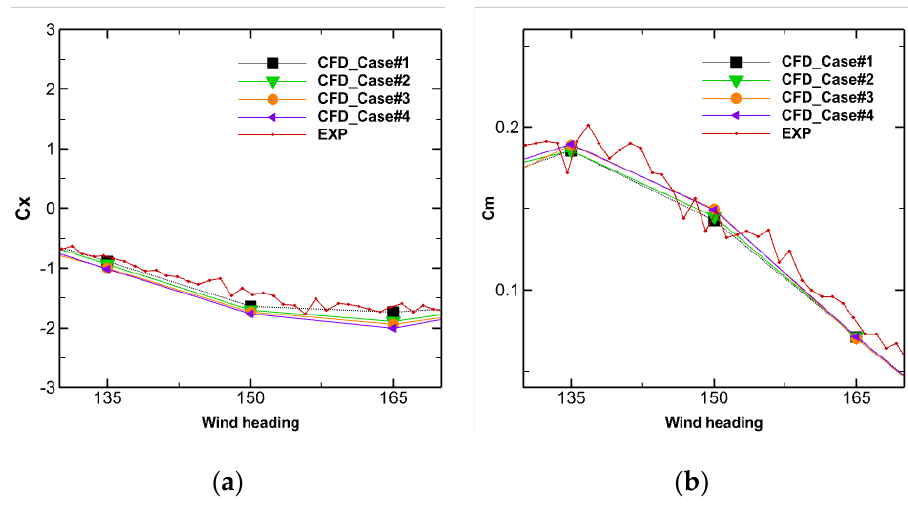
Figure 8. Comparison of aerodynamic coefficients on the FPSO for 4 cases. ( a ) forces; ( b ) moments.